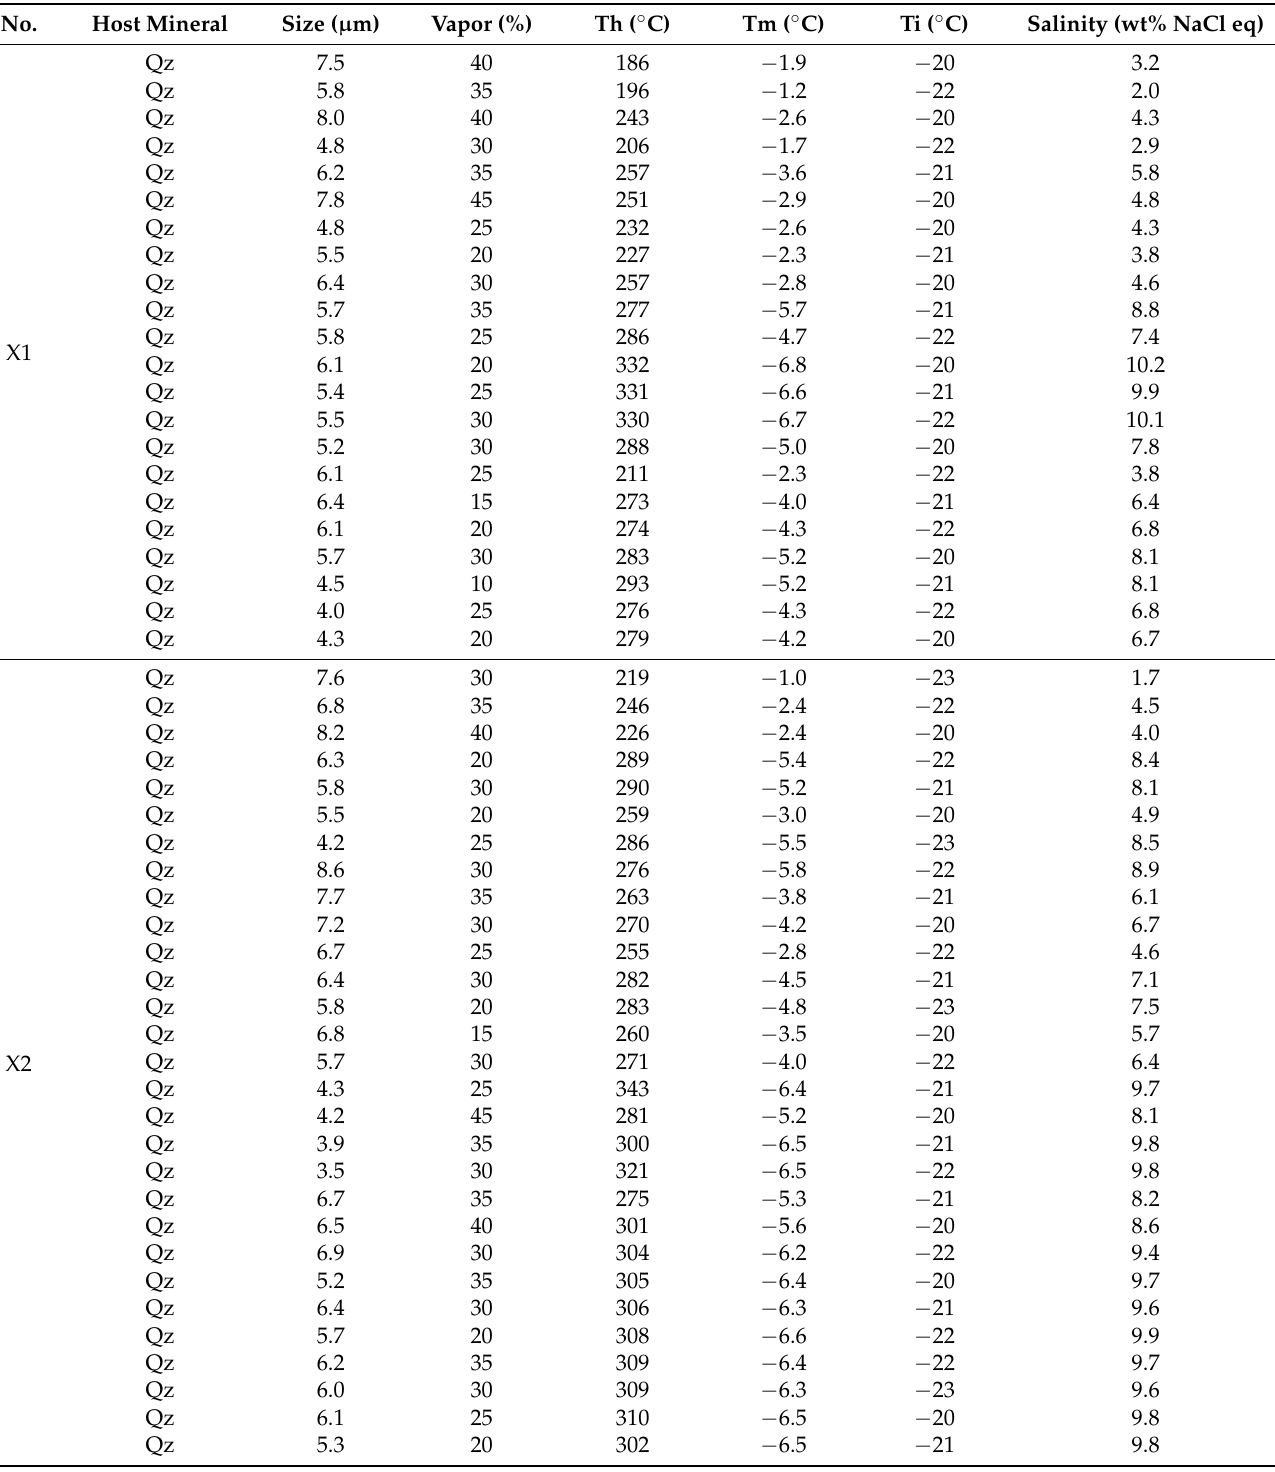
Table A1. Microthermometry results of primary fluid inclusions in Stage I of Xiaojiashan gold